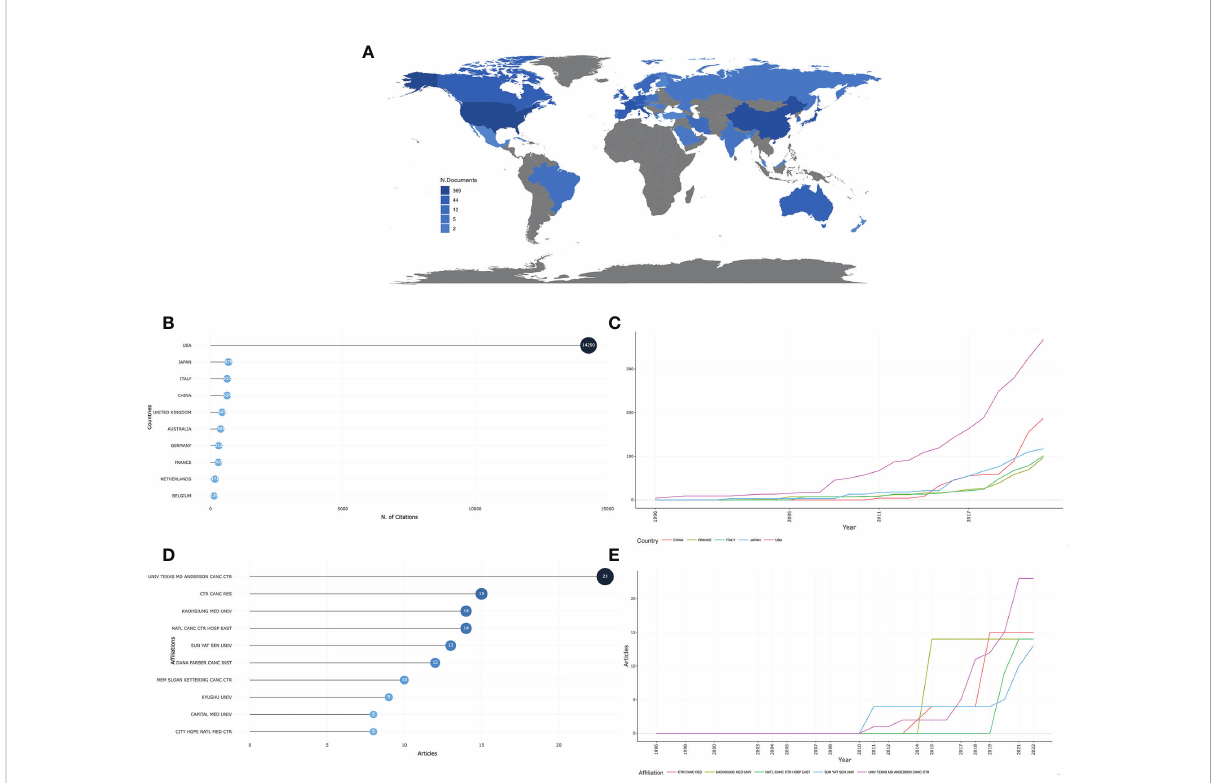
FIGURE 3 Countries and institutions contributing to IRAEs for colorectal cancer. (A) World map showing the distribution of countries in this fi eld. (B) Total number of citations of published research by country and region. (C) Growth curve of the number of publications per year for the top fi ve contributing countries and regions. (D) Distribution of the number of studies published by research institutions. (E) Growth curve of the number of publications per year for the top fi ve contributing